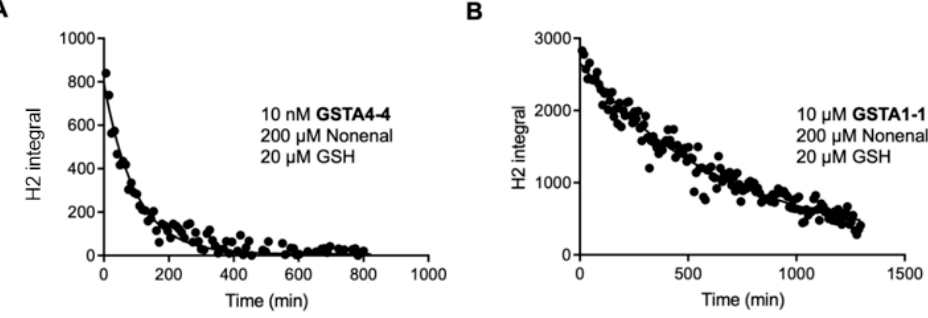
Figure 5. Exponential fits of 1 H-NE depletion with GSTA4-4 ( A ) or GSTA1-1 ( B ). Concentrations of reagents are shown in each panel. The integrated peak area of the C2 proton (H2) was fit to a single exponential decay. GSTA1-1 exhibits a detectable exchange but is much slower than GSTA4-4. Table 2. Rate of 1 H-NE depletion (k ex ) and GS-NE formation (k cat,f ) and for GSTA4-4 and GSTA1-1. GSTA Isoform